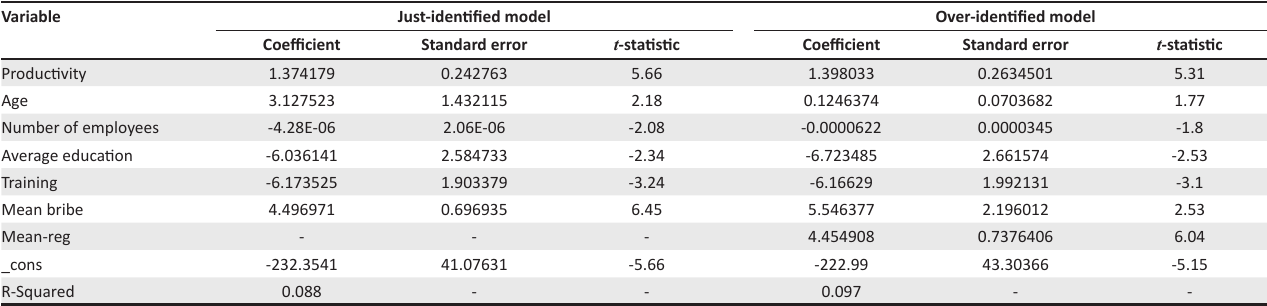
TABLE 1-A1: First stage